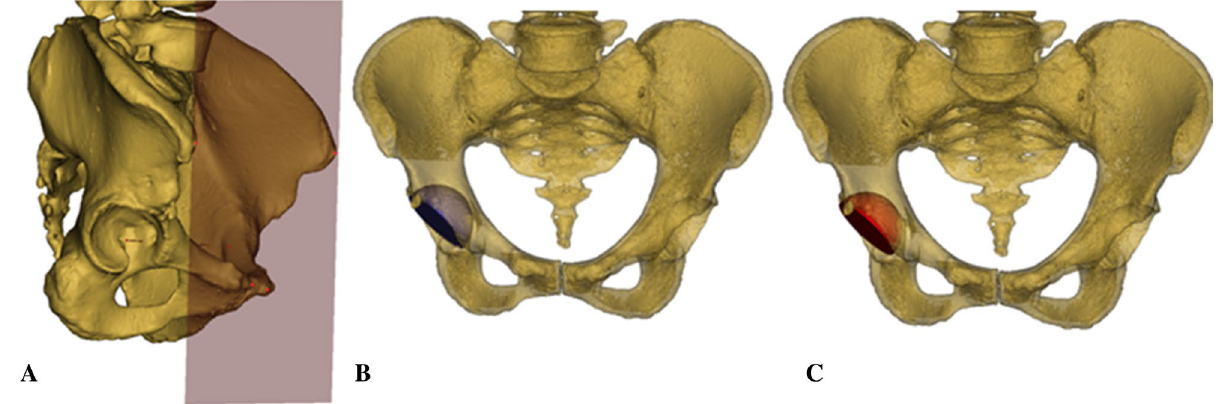
Figure 2. The 3D implantation simulations performed simultaneously in Mimics software. The pelvic position was standardized with reference to the anterior pelvic plane ( A ). The conventional reaming technique with cup inclination of 45° and anteversion of 15° ( B ). The anatomical technique with cup inclination of 45° and anteversion of 15° ( C